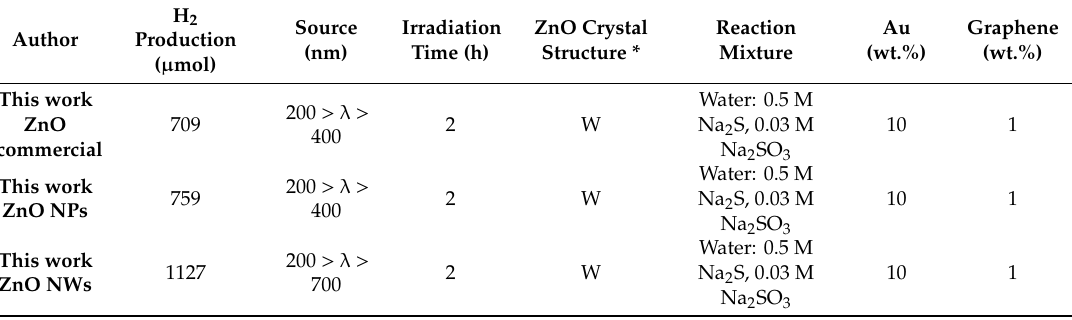
Table 2. Highest amounts of hydrogen production via water splitting obtained with Au@ZnO–graphene catalysts under UV–vis